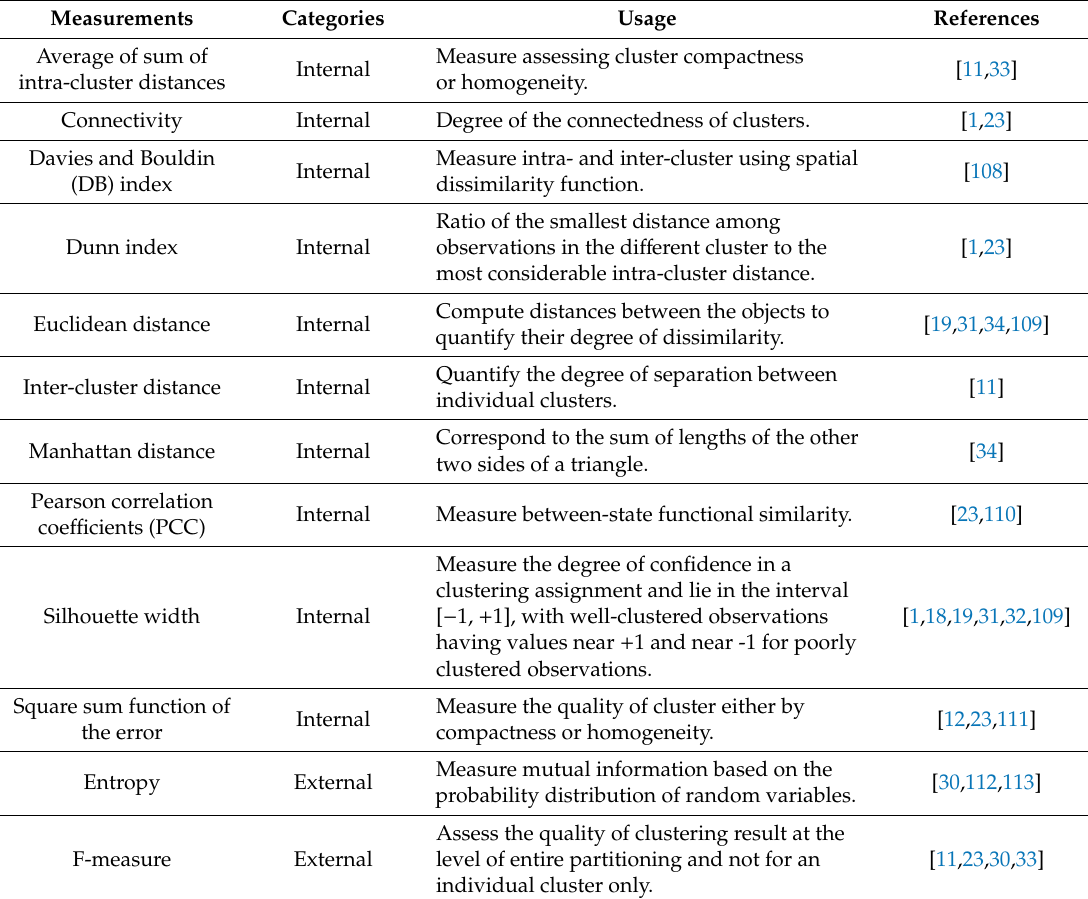
Table 7. Examples of previous studies in clustering